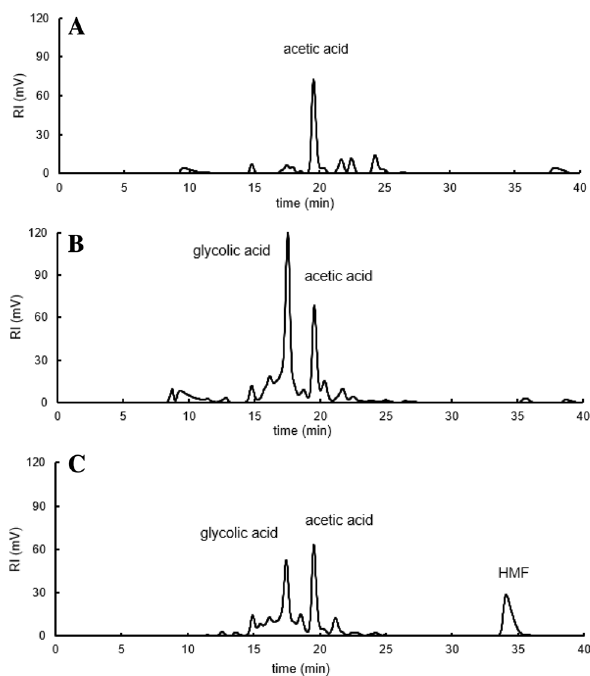
Fig. 8 HPLC elution profiles from the liquid phase following wood chip pyrolysis. a 300 °C, N